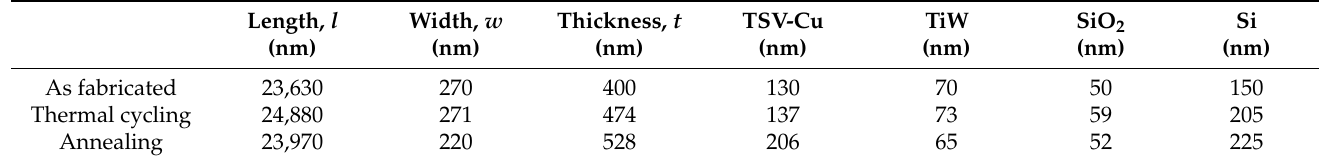
Figure 2. Schematic diagram of the micro cantilever beam sample: ( a ) SEM image of the micro cantilever beam for the Cu/TiW/SiO 2 /Si-interconnected structure; ( b ) SEM image of the removed sublayers. Table 1. Dimensions of the micro cantilever